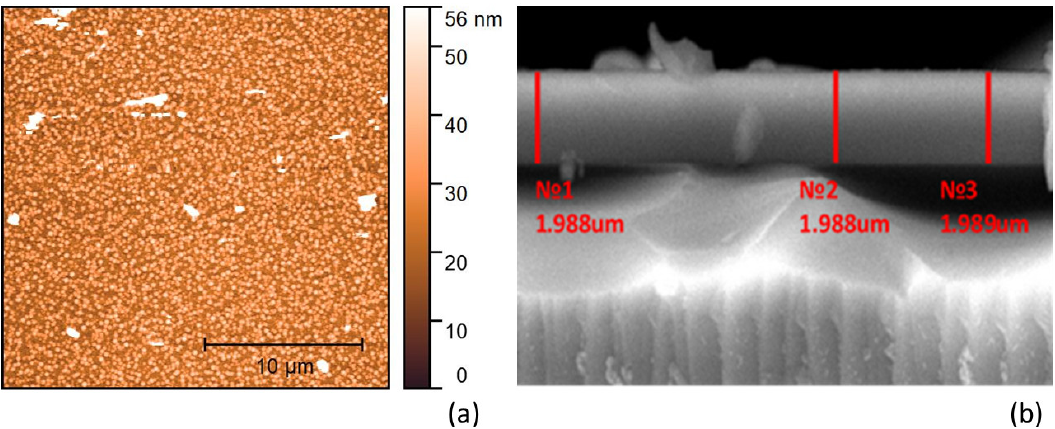
Figure 2. Surface and cross-section images of the As 98 Te 2 film: ( a ) AFM picture; ( b ) scanning electron microscope (SEM) photo.